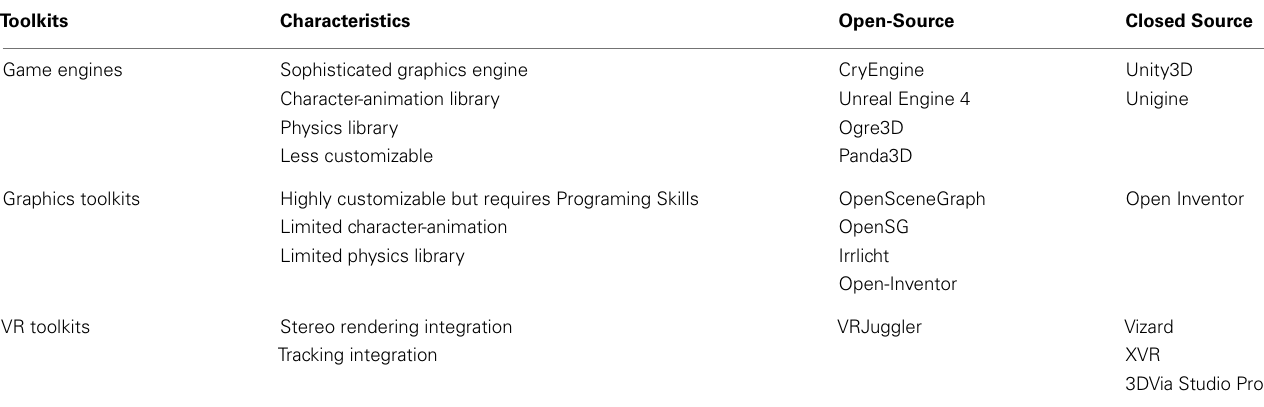
Table 2 | Summary of key characteristics for theVR module over various systems